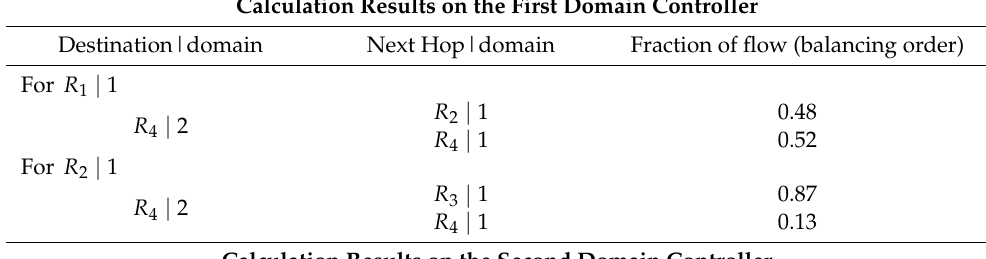
Table 6. Forwarding order for inter-domain QoS routing shown in Figure 10. Calculation Results on the First Domain